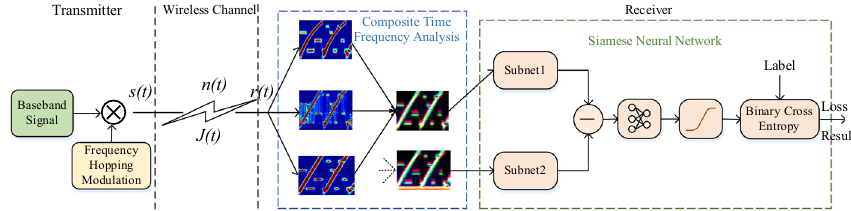
Fig. 1 Flowchart of interference